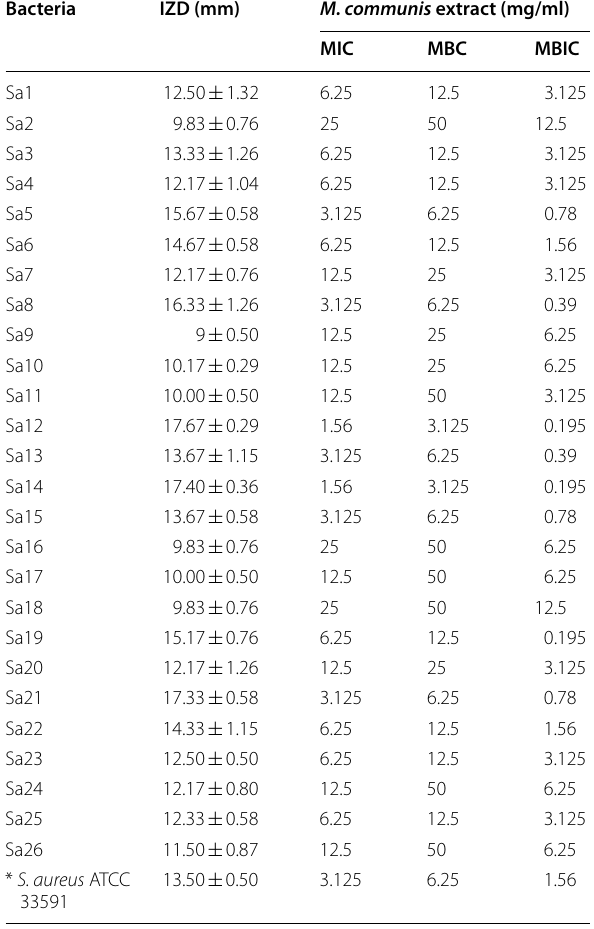
Table 4 The M. communis extract’s MIC, MBC, and MBIC toward MRSA strains isolated from clinical samples Bacteria